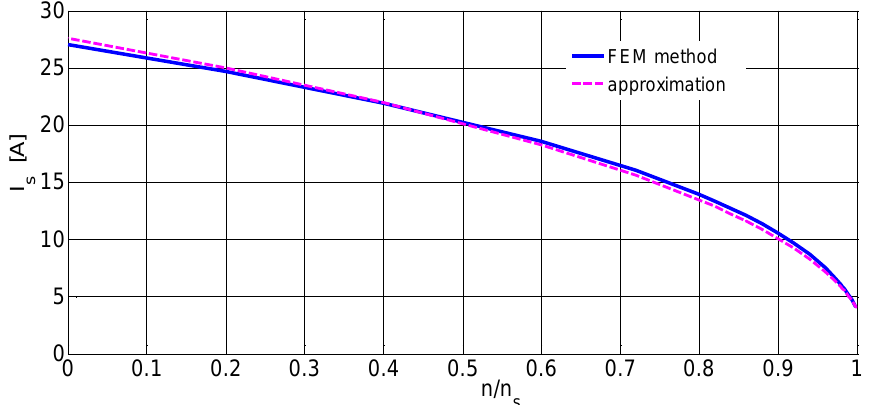
0 Figure 15. The dependence of the stator current on the rotational speed. Figure 15. The dependence of the stator current on the rotational